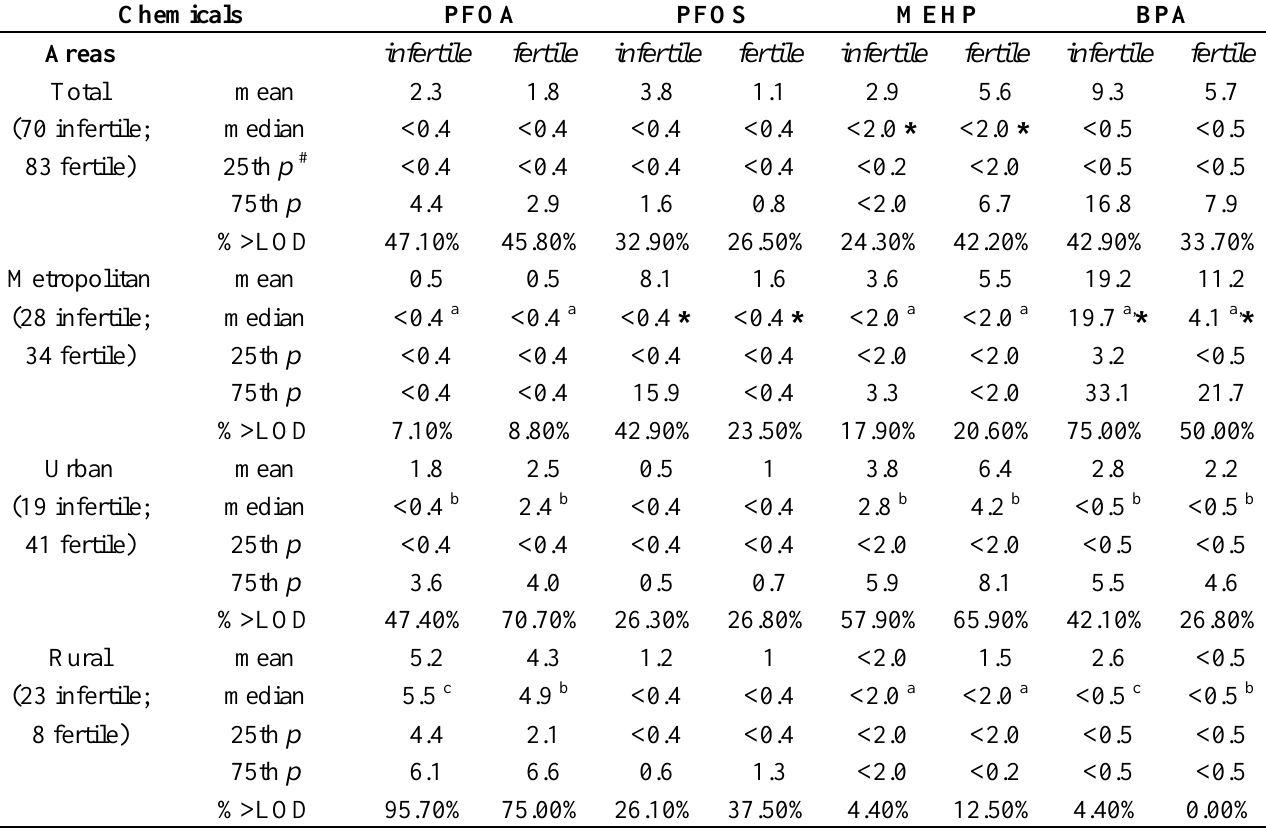
Table 3. Analytical values of PFOS, PFOA (ng/mL blood), MEHP and total BPA (ng/mL serum) in enrolled men grouped by area of residence and subject